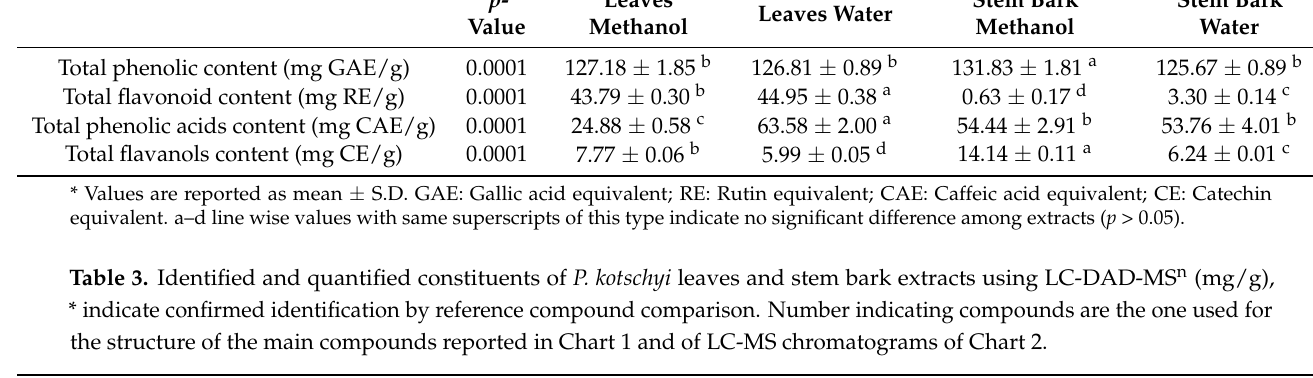
Stem Bark Water